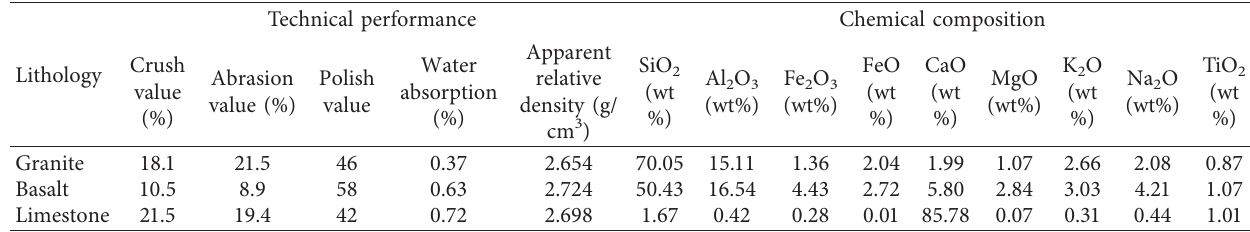
Table 2: Basic technical properties and mineral composition of the aggregate.